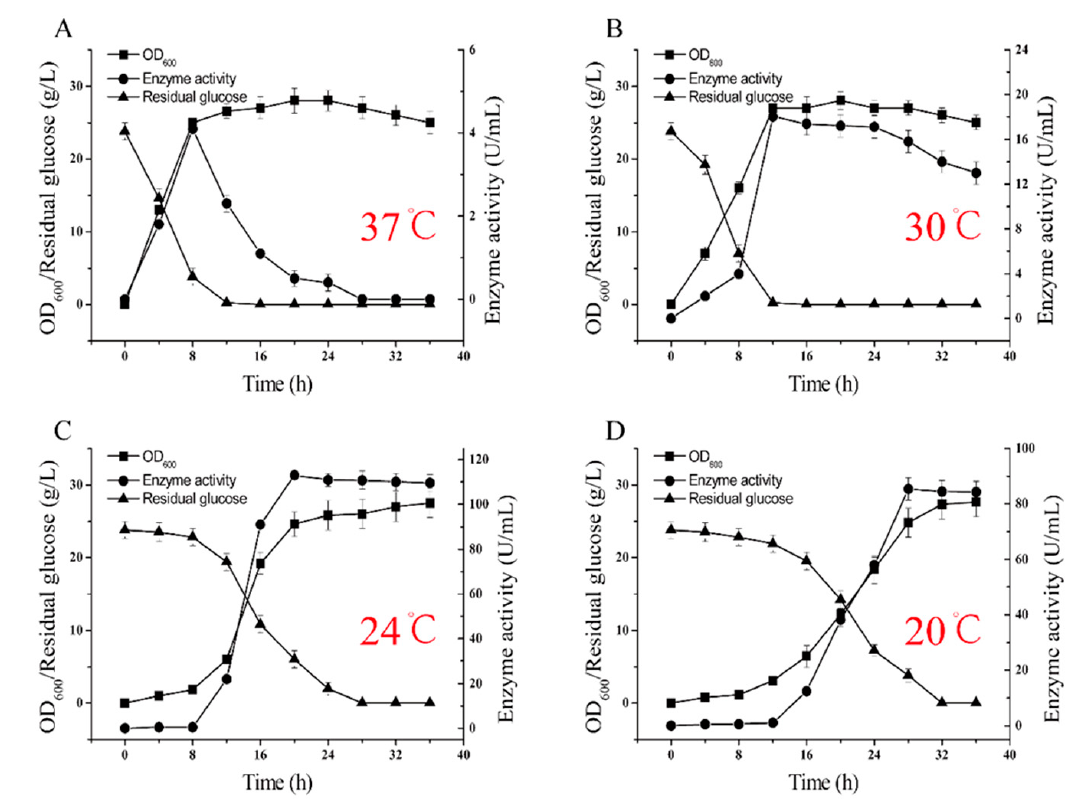
Figure 5. The effect of temperature on the fermentation of glutaminase. ( A ) Glutaminase fermentation at 37 °C; ( B ) glutaminase fermentation at 30 °C; ( C ) glutaminase fermentation at 24 °C; and ( D )